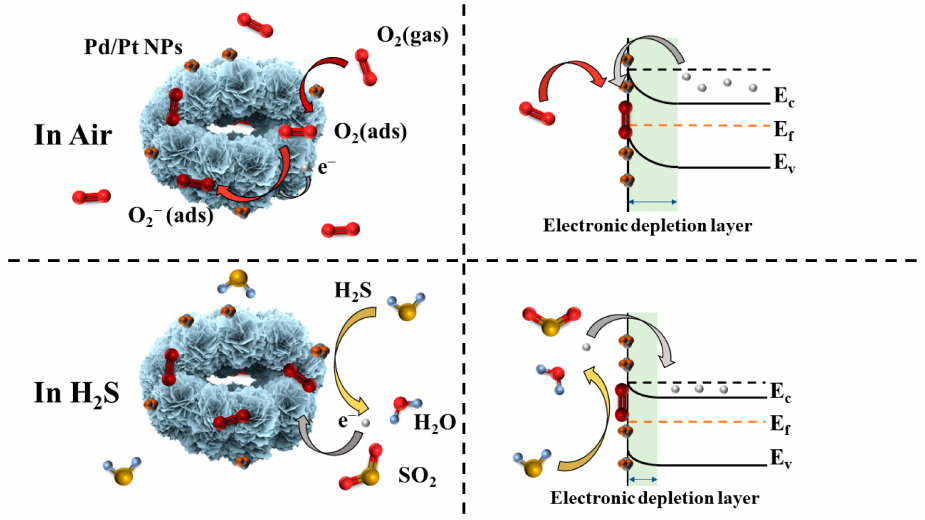
Figure 9. Demonstration of gas-sensing mechanism of 1 at% Pd/Pt-In 2 O 3 . The left side is a simulation diagram of the microsphere, and the right side is an energy-band